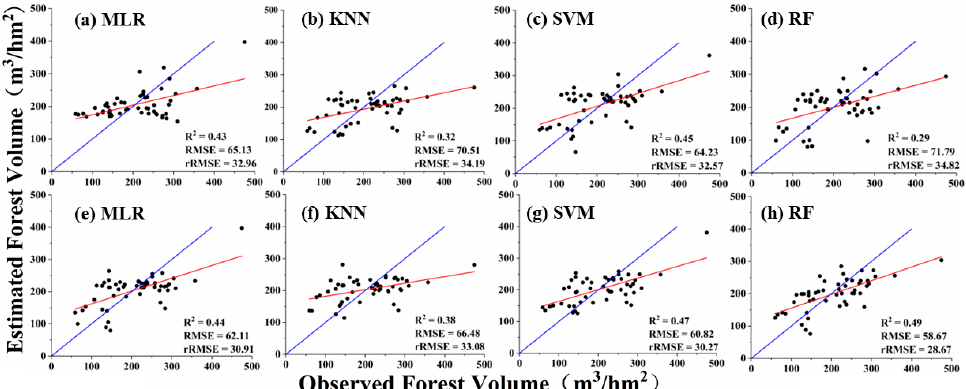
Figure 6. Scatter plots between measured and predicted GSV with different feature selection methods and models using GF-1 images; ( a – d ) show the results using Pearson correlation and ( e – h ) show the results using the proposed method.